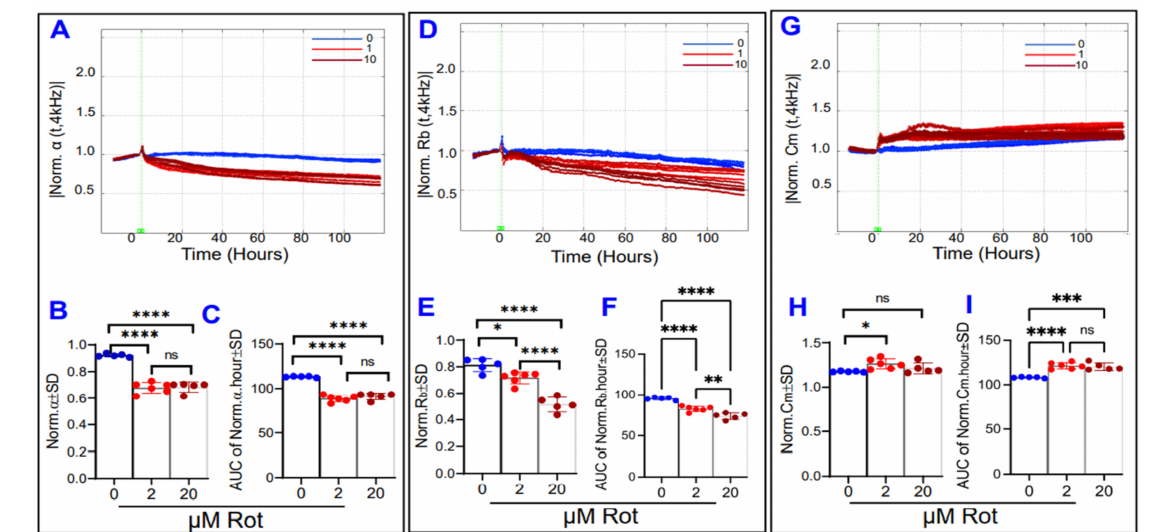
Figure 10. Real-time measurement of α , R b , and C m in ARPE-19 cells in a state of ETC complex I inhibition. ( A ) Normalized α measured at 4000 Hz vs. time (T) from the start of treatment at T = 0 to 100 h after initiation of treatment with a rotenone (Rot) concentration of 0, 2, or 20 µ M. ( B ) Comparison of α values measured at T = 100 h, the end of the experiment. Both low and high-dose Rot had the same effect on α endpoints. ( C ) Areas under the curve (AUC) of normalized α for the time from treatment start to experiment end. By the end of the experiment, complex I inhibition resulted in significant reductions to α in a non-dose-dependent fashion. ( D ) Normalized R b measured at 4000 Hz vs. time (T) for the interval T = 0–100 h. ( E ) Comparison of R b values at T = 100 h. Rot exerted a dose-dependent effect on endpoint R b . ( F ) Areas under the curve of normalized R b for the time T = 0–100 h. Rot treatment also had a dose-dependent effect on the R b behavior throughout the experiment. ( G ) Normalized C m measured at 4000 Hz vs. time (T) from T = 0–100 h. ( H ) Comparison of C m values measured at the experimental end, where only low dose changed the C m . ( I ) Areas under the curve of normalized C m for the time T = 0–100 h. Both Rot treatments resulted in C m alterations compared to control within the 100 h after treatment, though these Rot groups did not differ from each other. Abbreviations: Norm, normalized; AUC, area under the curve; ns, no significance. Data shown are the mean ± SD of 5–6 independent biological replicates per group. p values are * p ≤ 0.05, ** p ≤ 0.01, *** p ≤ 0.001, and **** p ≤